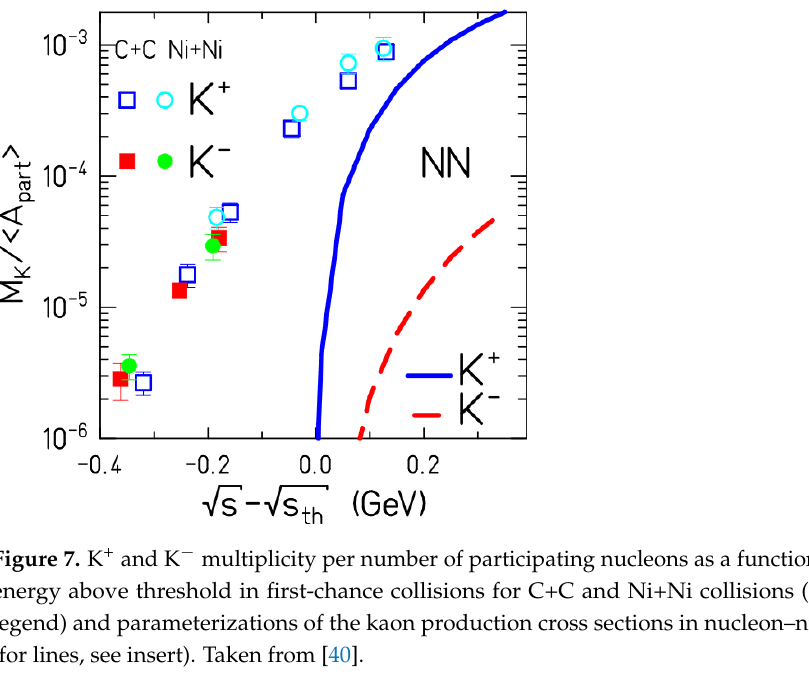
Figure 8. Inclusive invariant cross-sections at mid-rapidity as a function of the kinetic energy E c . m . − m 0 c 2 for K + mesons ( a ) and for K − mesons ( b ) for the various collision systems and beam energies